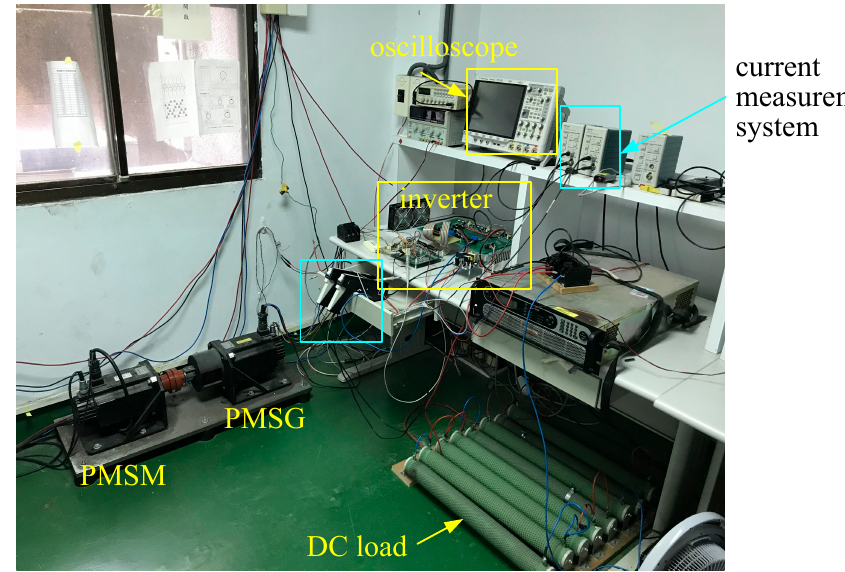
Figure 3. Experimental equipment for the PMSG system based on the IT2 T-S fuzzy systems.